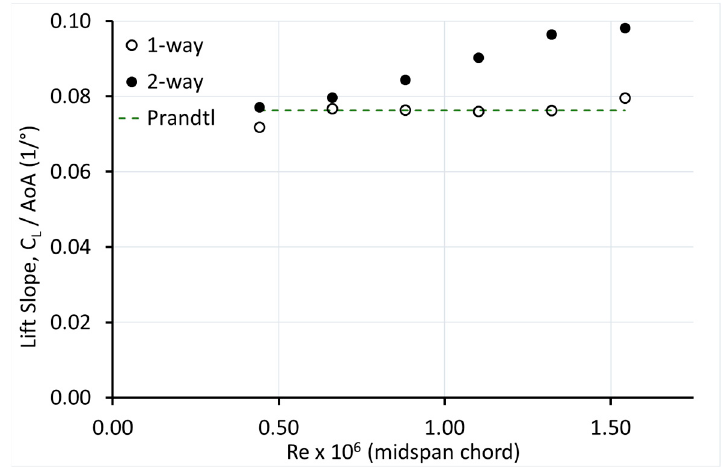
Figure 14. Lift slope vs. Reynold’s number.